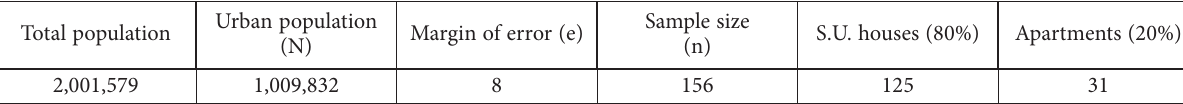
Table 2. Sample size (Pakistan Bureau of Statistics, 2017; Yamane,